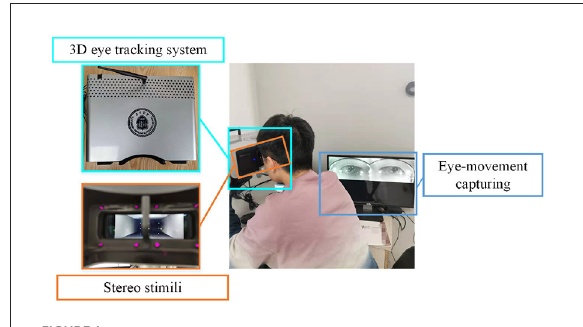
FIGURE1 The user-friendly data collection scene with the self-designed 3D eye-tracking